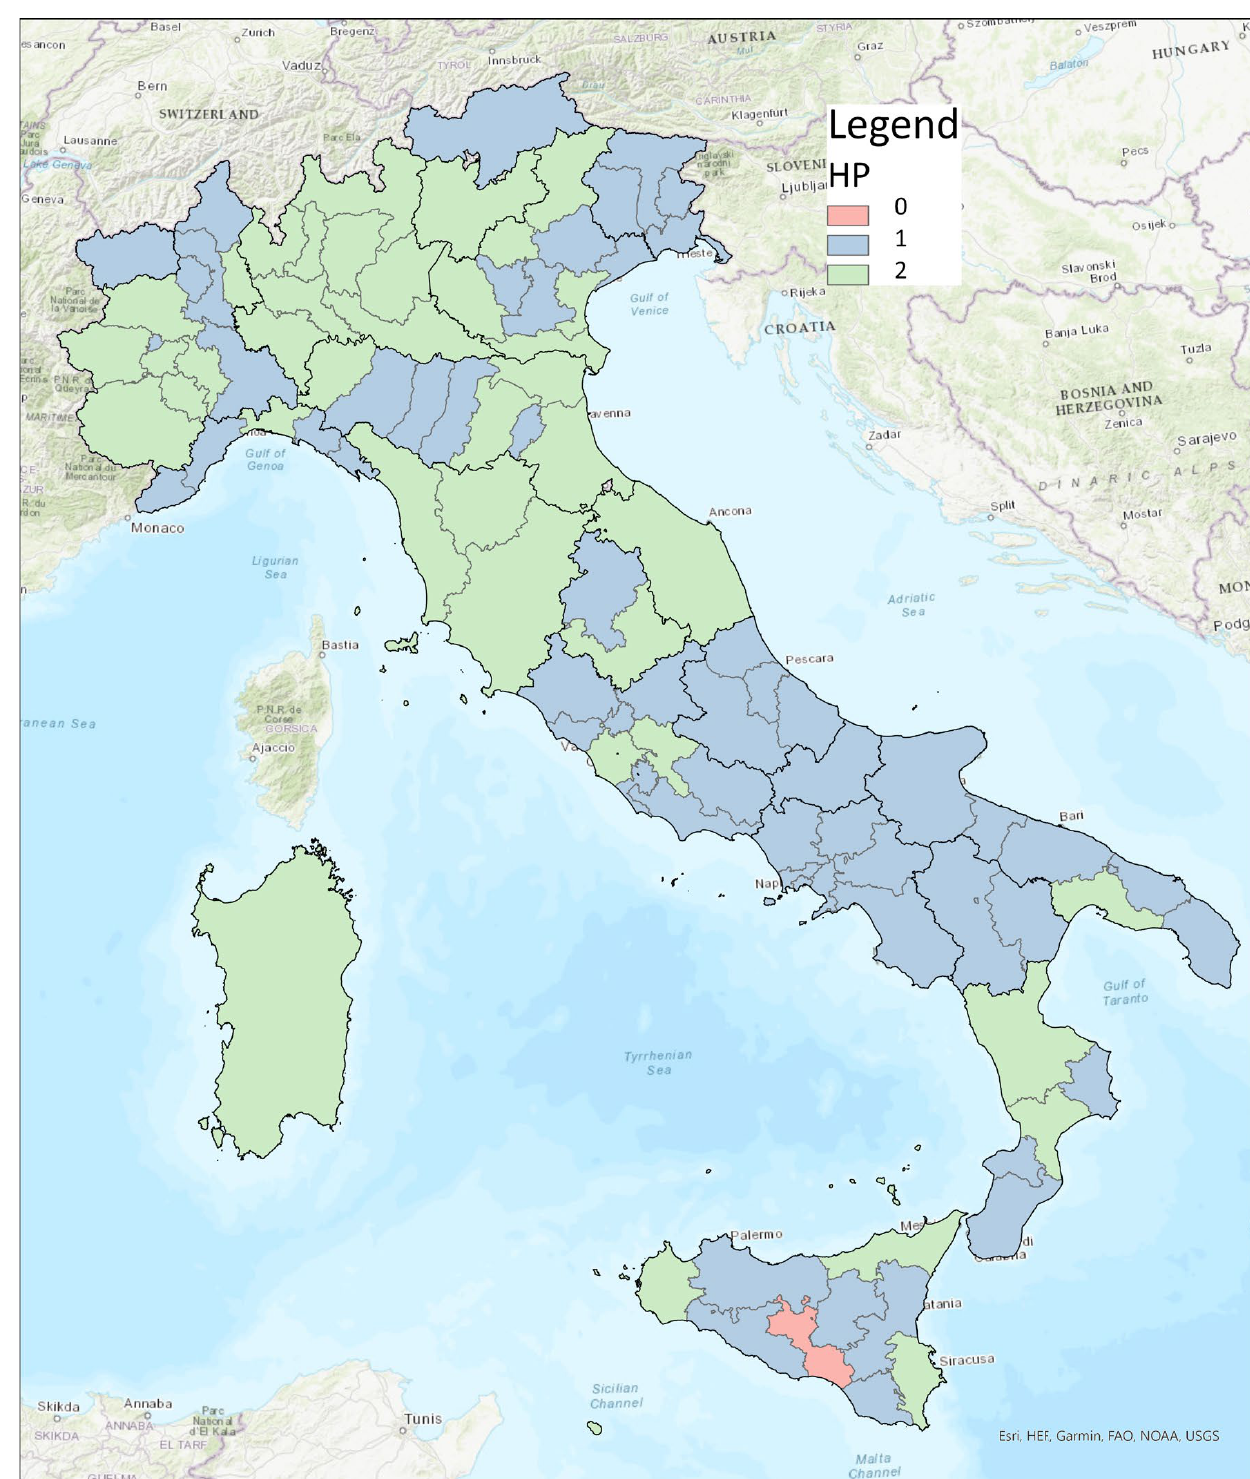
Figure 3. Distribution of LHAs involved in health promotion in Italy.